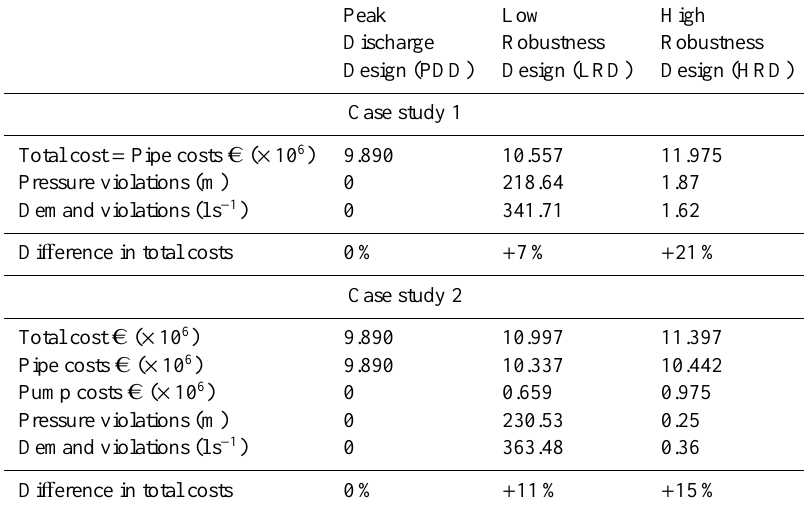
Table 4. Total cost di ff erences for the two case